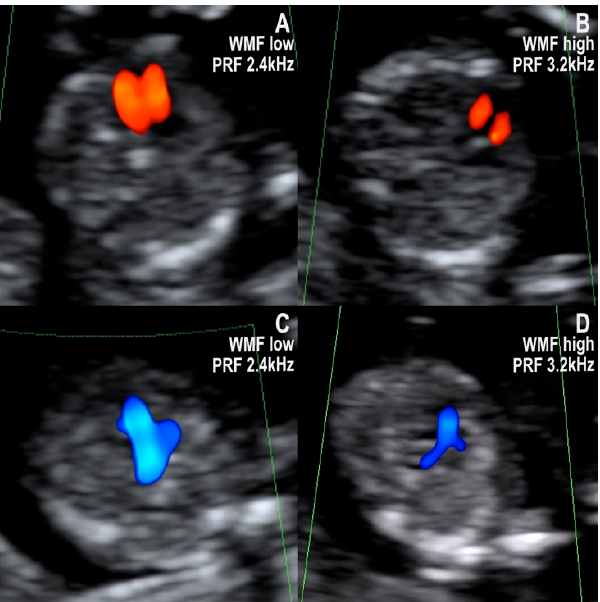
Figure 4. Color doppler flow patterns of the four-chamber, and three-vessel, and trachea views obtained using low and high PRF/WMF doppler settings in a normal 12–13-week fetus. ( A ): Low PRF/WMF doppler settings allow better visualization of the size and filling of the ventricles in the four-chamber view. ( B ): High PRF/WMF doppler settings are preferred to verify the distinct filling of the ventricles. ( C ): Low PRF/WMF doppler settings offer adequate visualization of the ductal and aortic arches. ( D ): High PRF/WMF doppler settings can impair the visualization of the aorta.